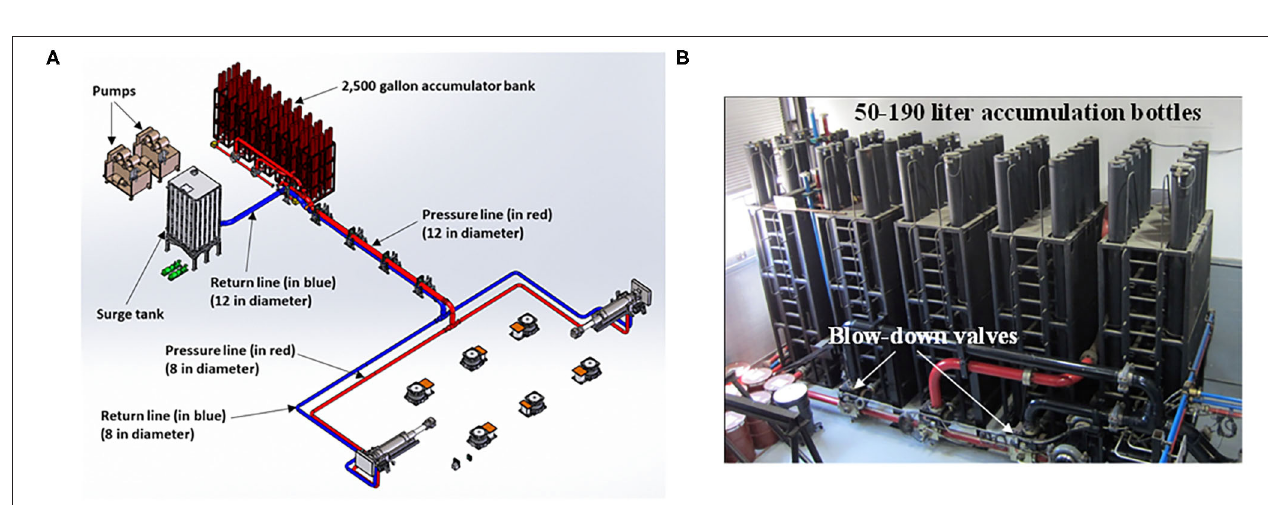
FIGURE 3 | (A) Hydraulic power system for the 1-DOF LHPOST, and (B) accumulator